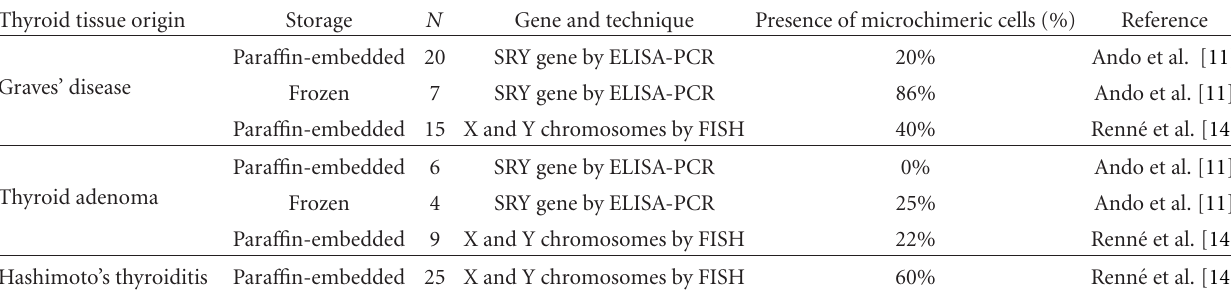
Table 1: Summary of the main experimental and clinical findings of Graves’ disease and